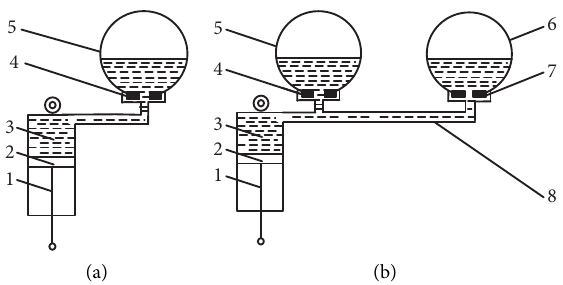
Figure 2: Schematic of (a) single-chamber and (b) dual-chamber hydro-pneumatic suspension.